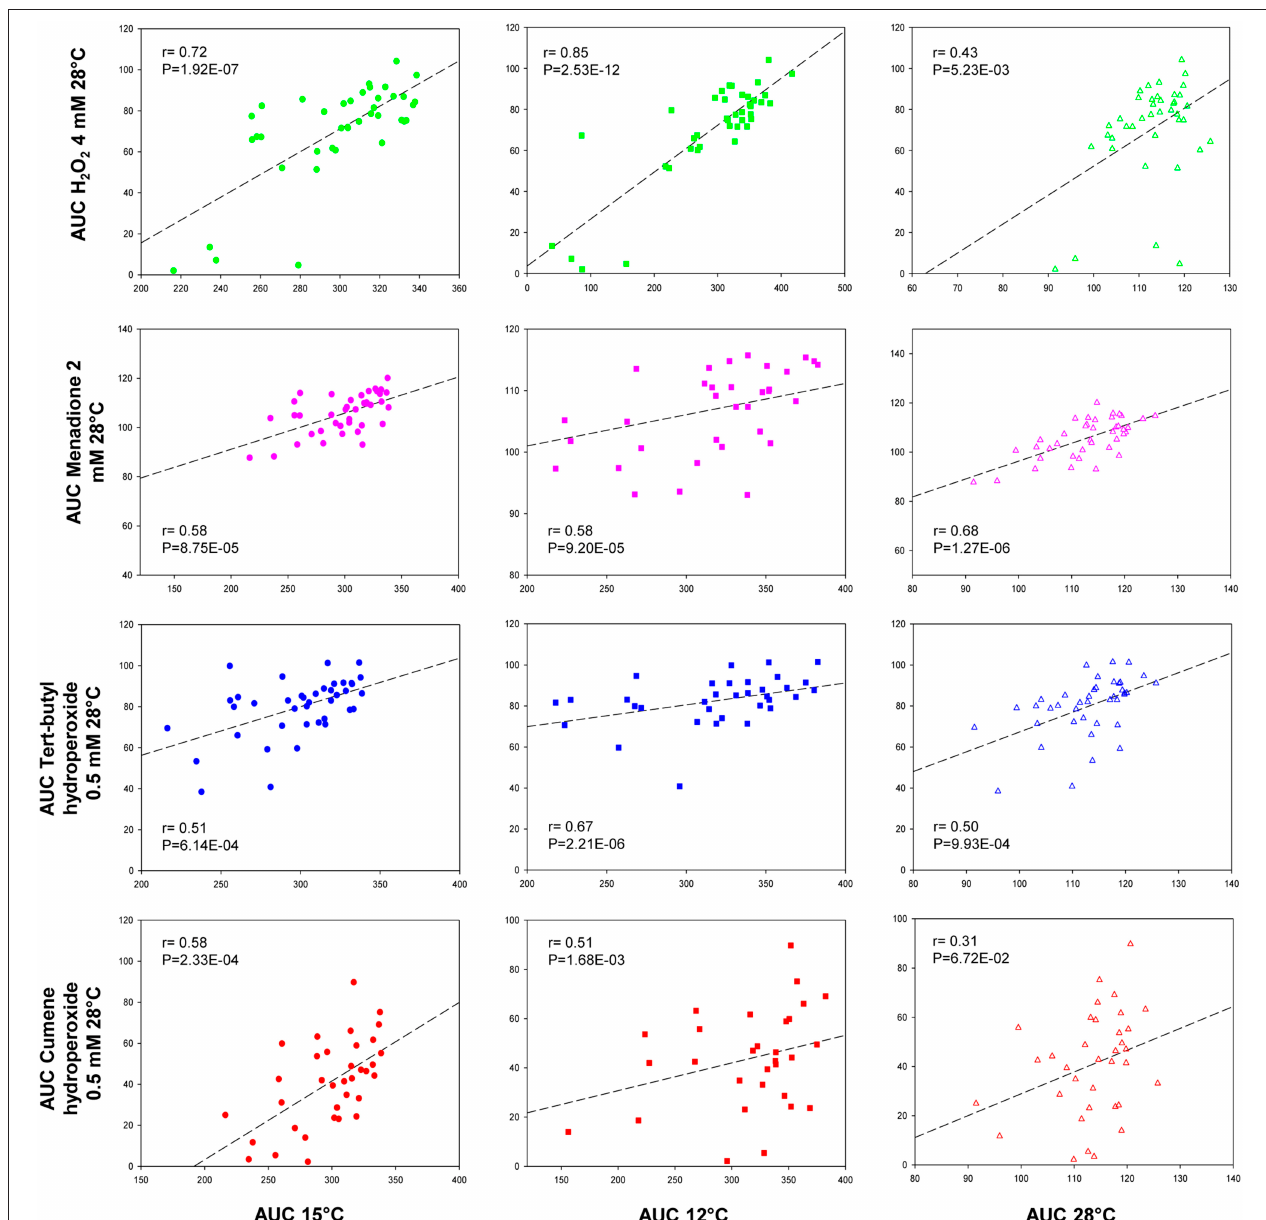
FIGURE 2 | Correlation analysis between temperature and oxidant agents. The mean AUC value in SM at 15, 12, and 28 ◦ C was plotted against the mean AUC value under each oxidative condition. Linear regression (black line) is displayed. The squared Pearson correlation coefficient (r) and the p -value are provided in this